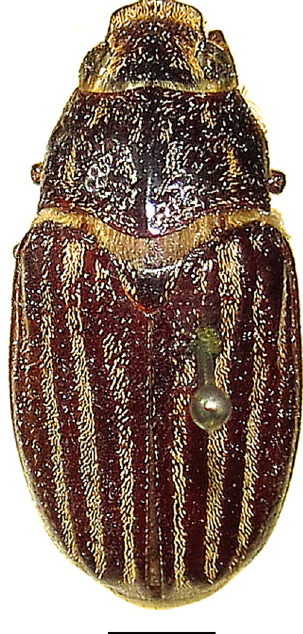
Fig. 1. Engertia allolepis sp. nov., habitus, holotype, ♂ (MNHN). Scale bar = 2.5